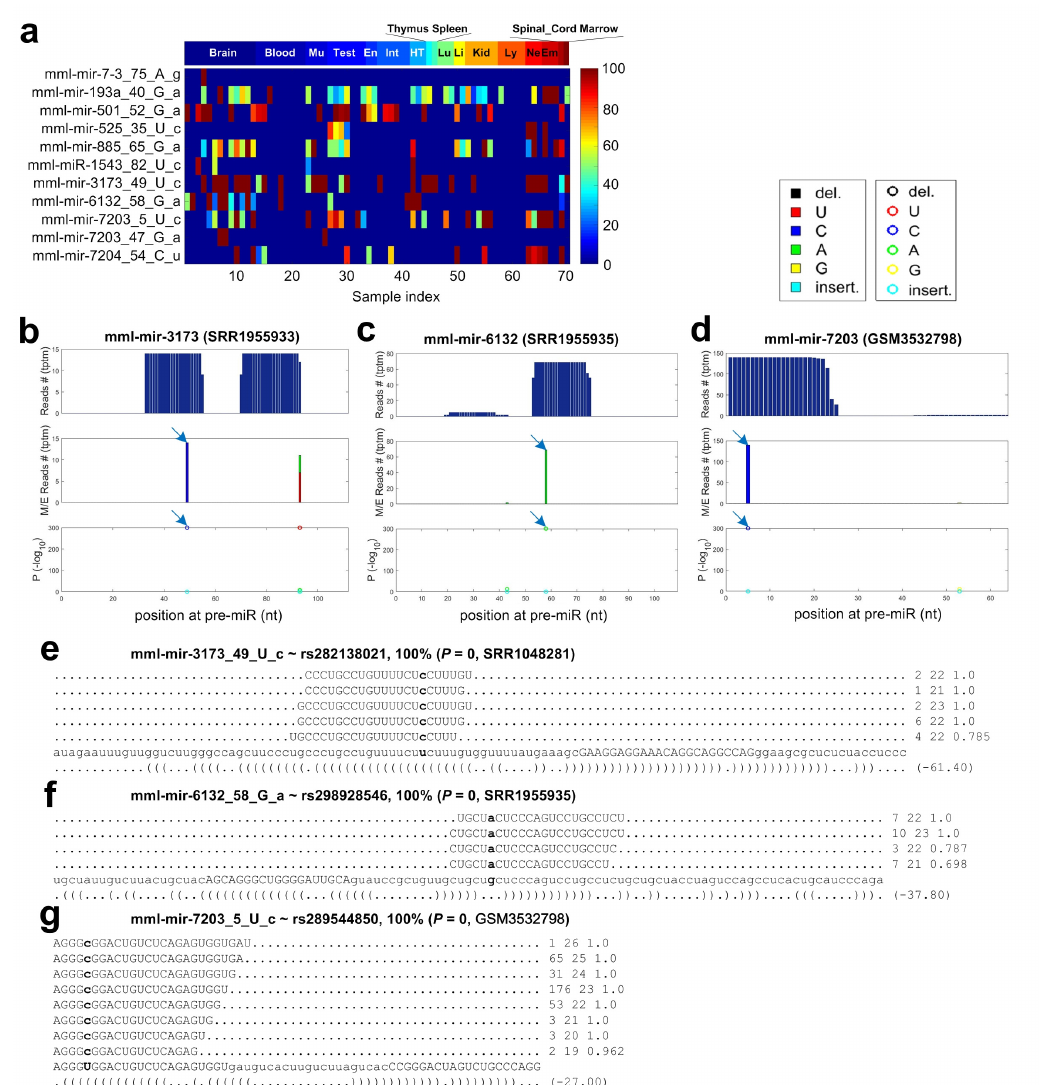
Figure 6. The details of 11 SNPs identified in miRNAs of Macaca mulatta . ( a ) The editing/mutation levels of the 11 SNP sites in the 70 selected sRNA-seq profiles. ( b ) The MiRME map of mml-mir-3173 in the bone marrow sample selected (SRR1955933). ( c ) The MiRME map of mml-mir-6132 in the one of the brain samples selected (SRR1955935). ( d ) The MiRME map of mml-mir-7203 in the spinal cord sample selected (GSM3532798). ( e ) The details of mml-mir-3173_49_U_c, i.e., rs282138021, in SRR1955933. ( f ) The details of mml-mir-6132_58_G_a, i.e., rs298928546, in SRR1955935. ( g ) The details of mml-mir-7203_5_U_c, i.e., rs289544850, in